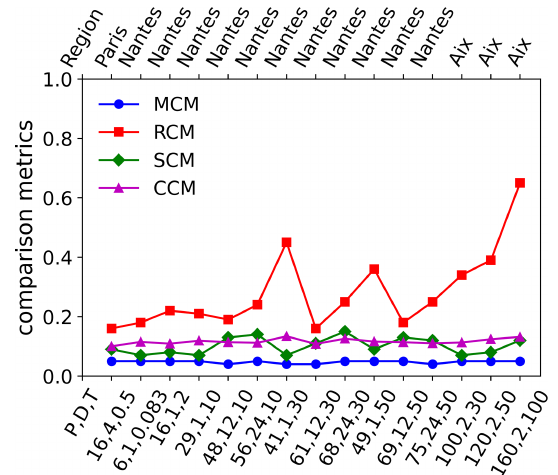
Figure 7. Multi-fractal comparison metric, rainfall comparison met- ric, singularity comparison metric and codimension comparison metric for all the different reference rainfall simulations. P , D , and T are in units of mm, hours and years